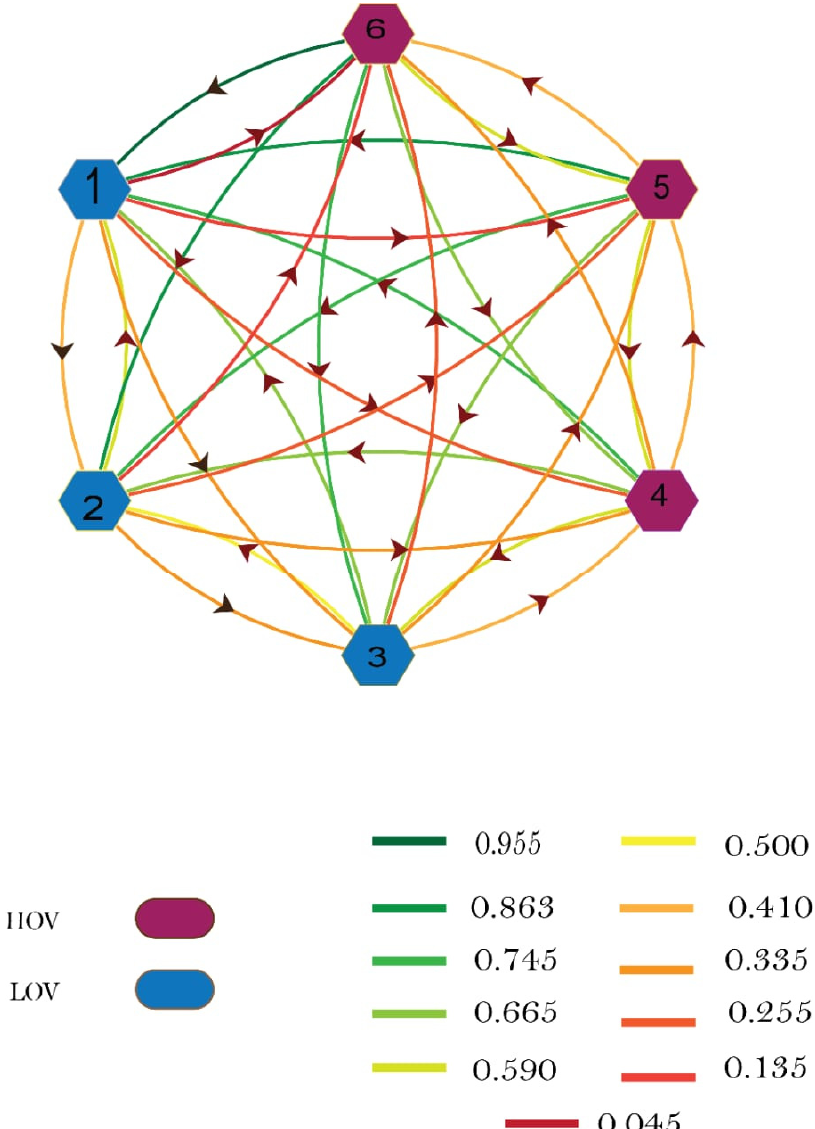
Figure 7. Graphical representation of relative importance between attributes.